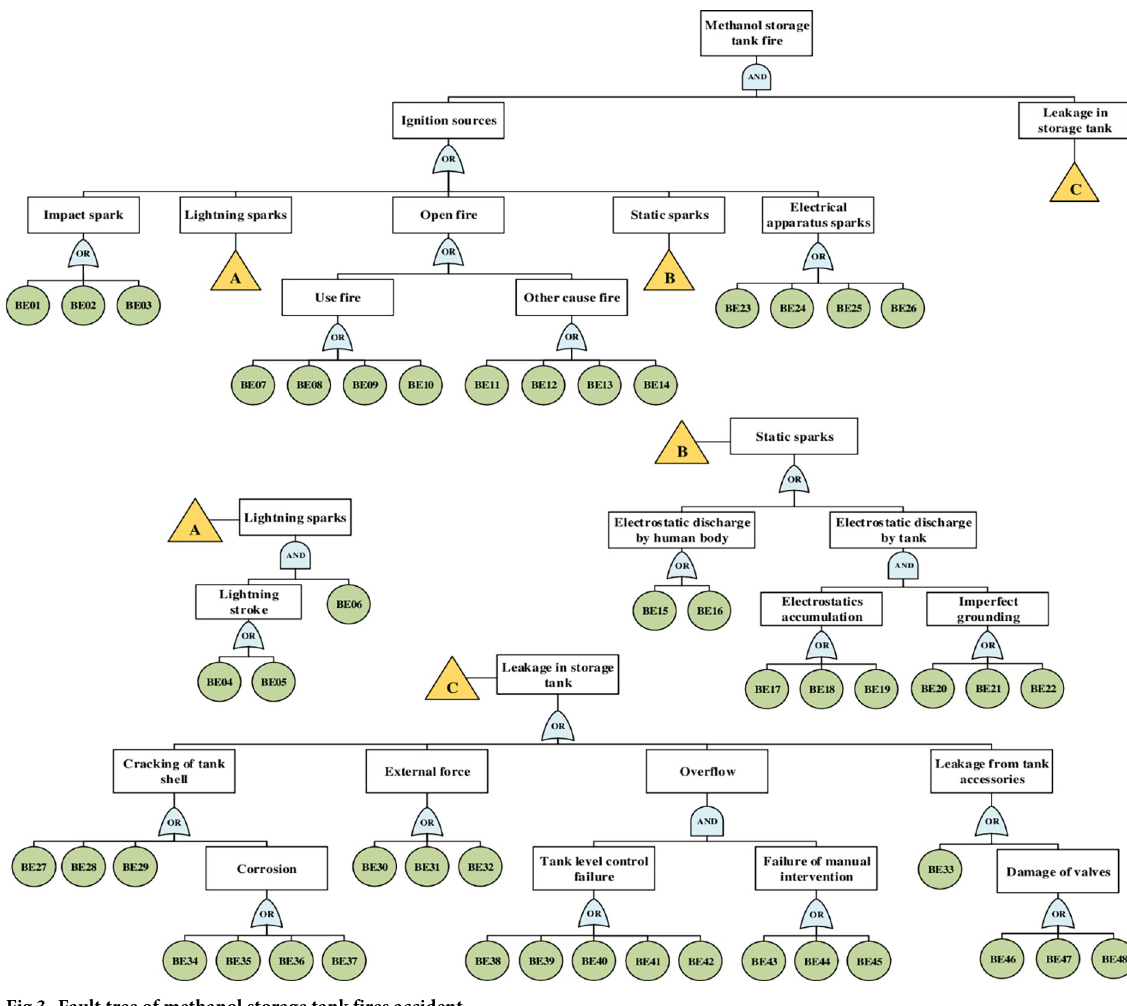
Fig 3. Fault tree of methanol storage tank fires